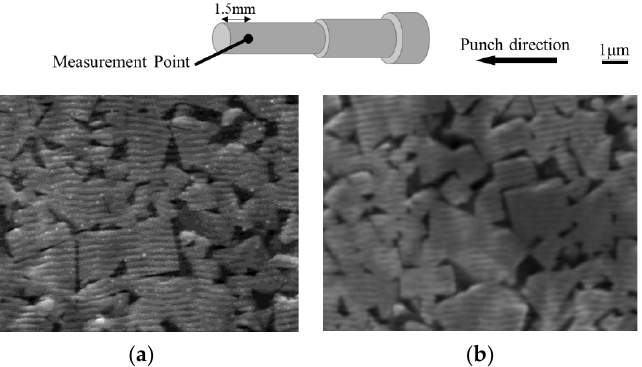
Figure 11. SEM images of the nanotextured punch before and after extrusion (punch side): ( a ) as received and ( b ) after extrusion (5th extrusion).